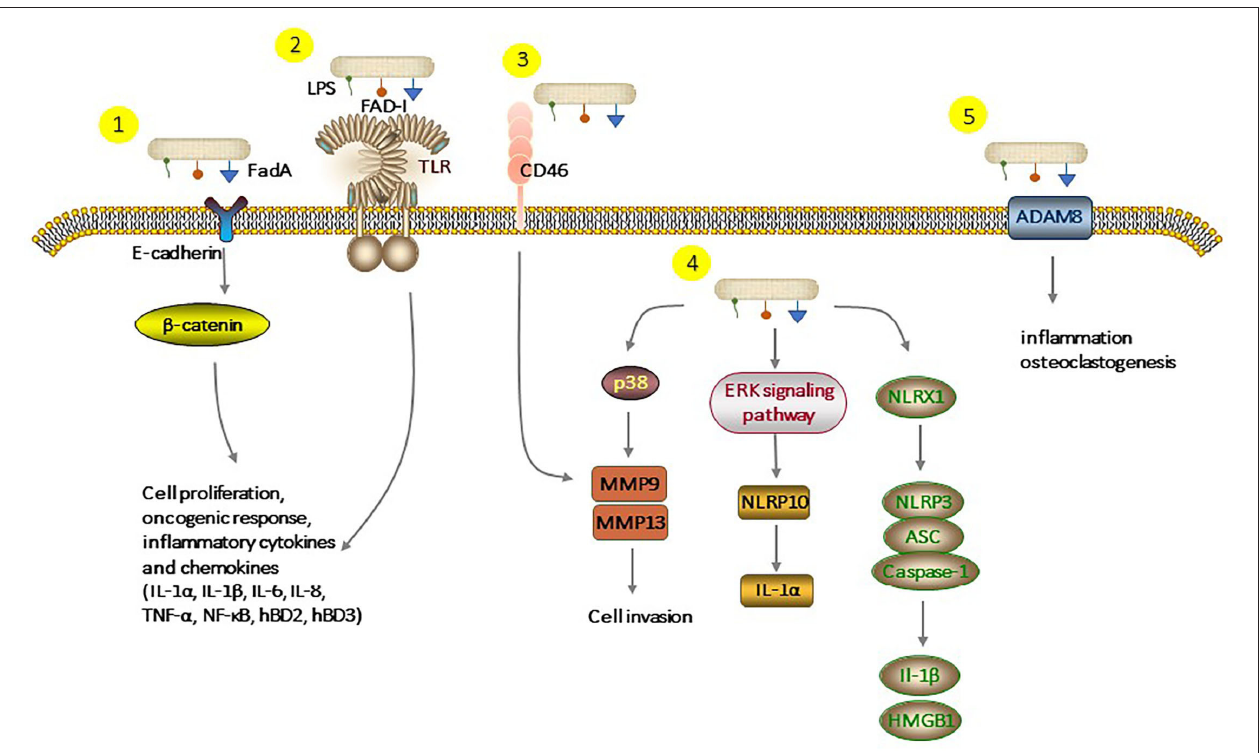
FIGURE 3 | Different pathways of interaction of F. nucleatum with epithelial cells. (1), FadA binding to E-cadherin activates β -catenin signaling, leads to cell proliferation, oncogenic, and inflammatory responses. (2), FAD-I can induce hBD2 expression via both TLR-1/2 and TLR-2/6. LPS and cell extracts of F. nucleatum can also increase production of inflammatory cytokines and chemokines. (3), F. nucleatum binds to CD46 which results in the overexpression of MMP-9. (4), F. nucleatum triggers the expression of MMP-9 and MMP-13 over the p38 signaling pathway, which causes invasion into the epithelial cell. Activation of the extraregular regulated protein kinases (ERK) signaling pathway augments the pro-inflammatory cytokine IL-1 α levels. F. nucleatum infection-triggered inflammatory response activates the NLRP3 inflammasome, which is enhanced by NLRX1. (5), Stimulation by F. nucleatum leads to upregulation of ADAM8 expression which is involved in inflammation and essential for osteoclastogenesis. LPS, Lipopolysaccharides; Fad-I, Fusobacterium -associated defensing inducer; FadA, Fusobacterial adhesion; NLRP, Nucleotide-binding oligomerization domain-like repeat protein; NLRX, Nucleotide-binding domain and leucine-rich-repeat-containing family member X; ADAM8, A disintegrin and metalloproteinase 8; ASC, Apoptosis-associated speck-like protein containing a carboxy-terminal CARD; MMPs, Matrix metalloproteinase.